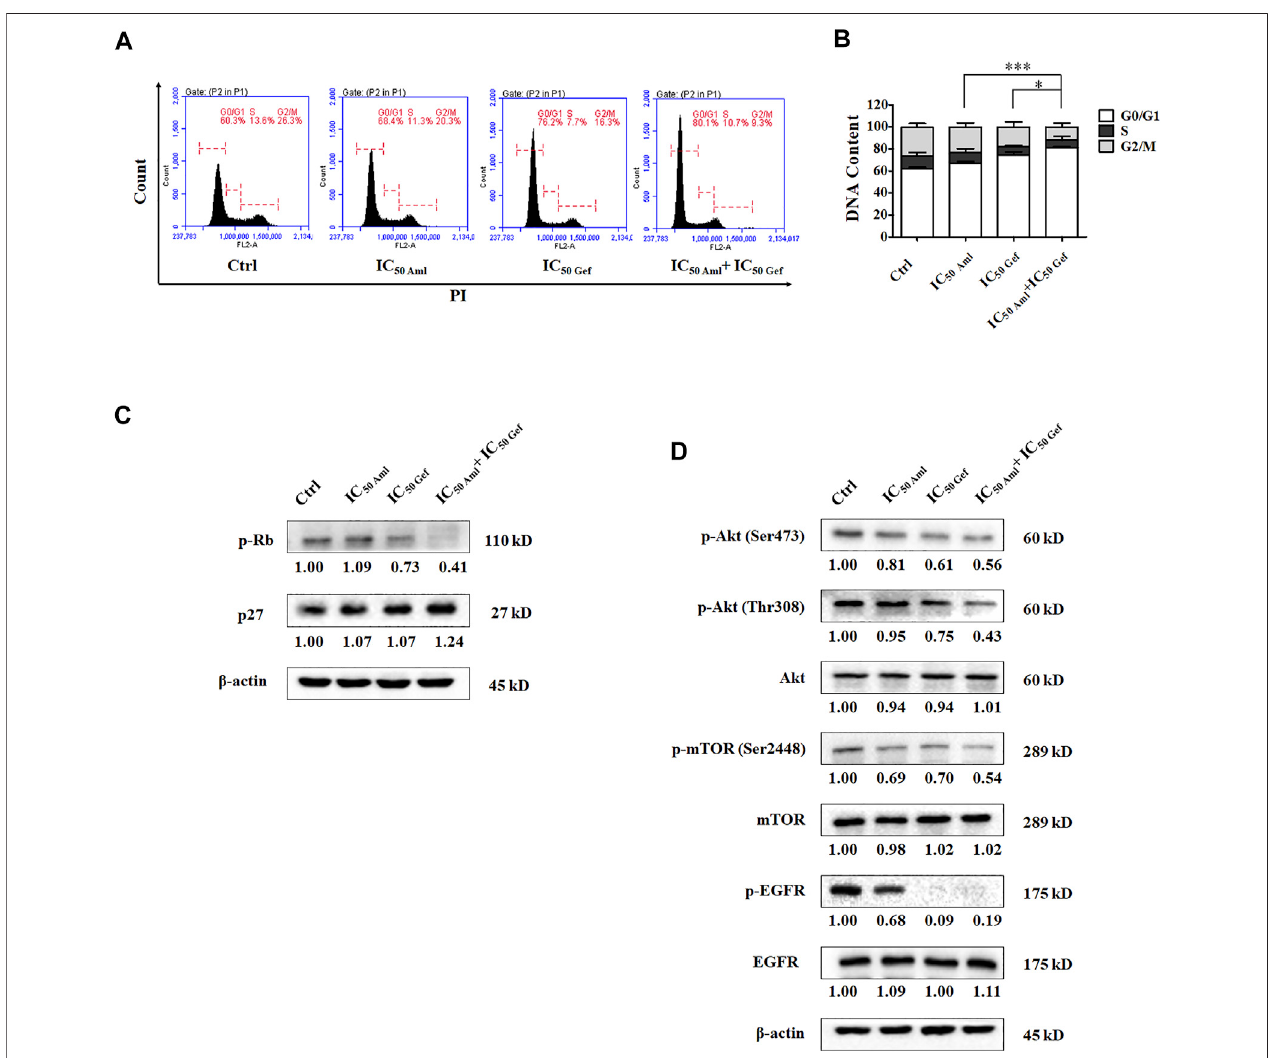
FIGURE 4 | Amlodipine combined with ge fi tinib induces cycle arrest in A549 cells. (A) Amlodipine combined with ge fi tinib increased the proportion of cells in the G0/G1 phase. (B) The percentage of total cells at G0/G1, S, and G2/M phases. (C) The levels of p-Rb and p27 were measured by Western blotting after treatment with amlodipine,ge fi tinib,oracombinationofthetwoagents. (D) PhosphorylationandtotallevelsofAkt,mTOR,andEGFRwereanalyzedbyWesternblottingaftertreatment with amlodipine, ge fi tinib, or a combination of the two agents. Data are presented as mean ± SD of three independent experiments. * p < 0.05 and *** p < 0.001.